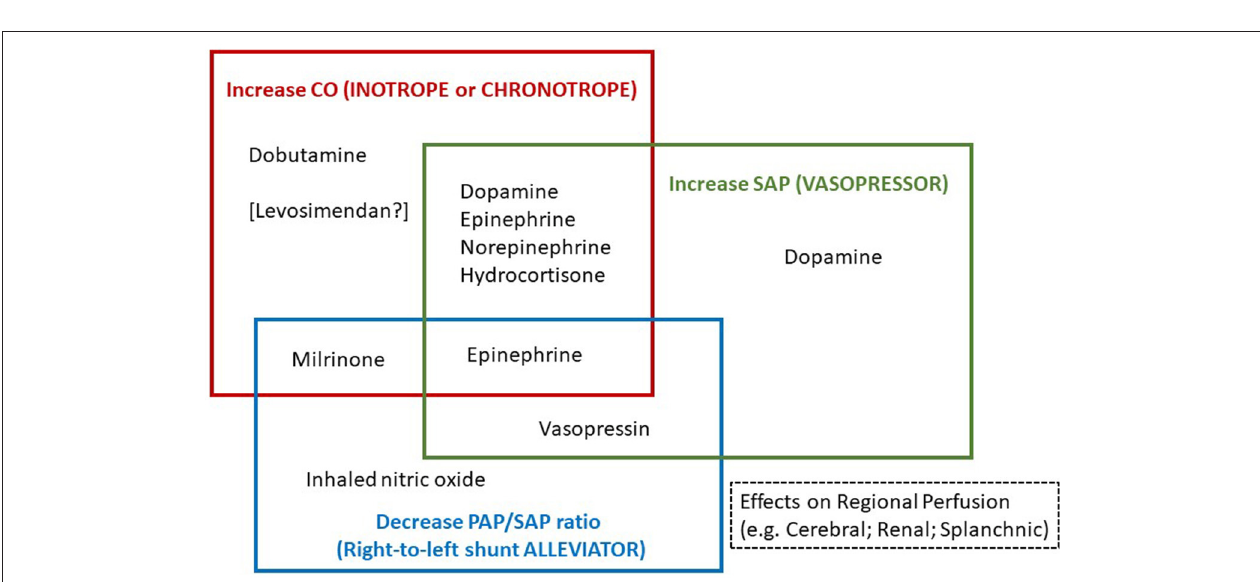
FIGURE 1 | A proposal of therapeutic approach in the cardiovascular support of asphyxiated neonates. The choice of cardiovascular medication(s) depends on the targeted approach for cardiac output and blood pressure management with improved oxygenation, organ perfusion and function which need to be balanced against the adverse effects of therapies. CFT, capillary filling time; CVP, central venous pressure; SpO 2 and SvO 2 , percutaneous (arterial) and venous oxygen saturation, respectively.